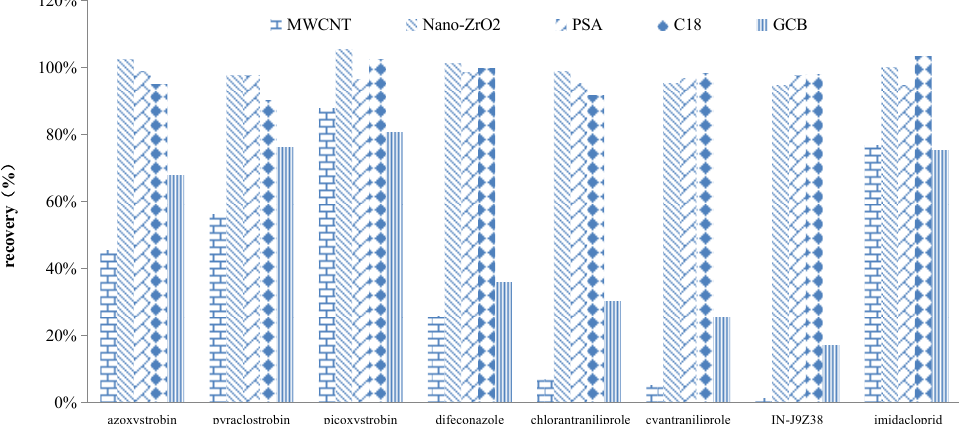
Figure 4. Absorption efficiency of five different adsorbent for eight targeted compounds. Table 2. Effect of adsorbent dosage on the recovery of eight targeted compounds in litchi and longan samples ( n =